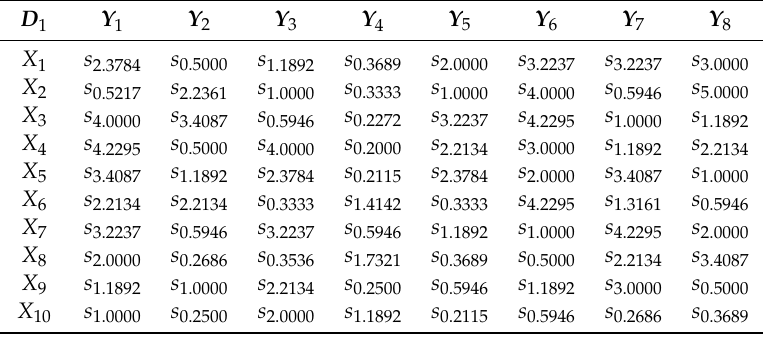
Table A6. Deterministic linguistic evaluation information matrix of D 1